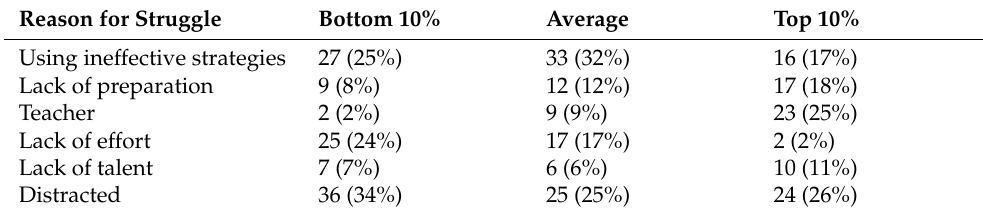
Table 1. Likely Reasons for Academic Struggles.